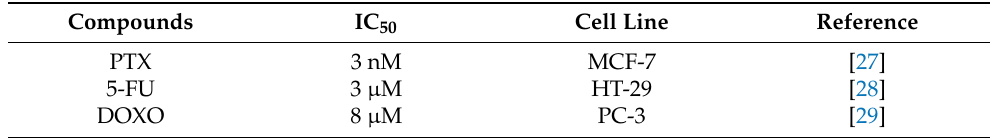
Table 3. IC 50 values of the antineoplastic agents PTX, 5-FU, and DOXO obtained from the literature and used in this study for combination